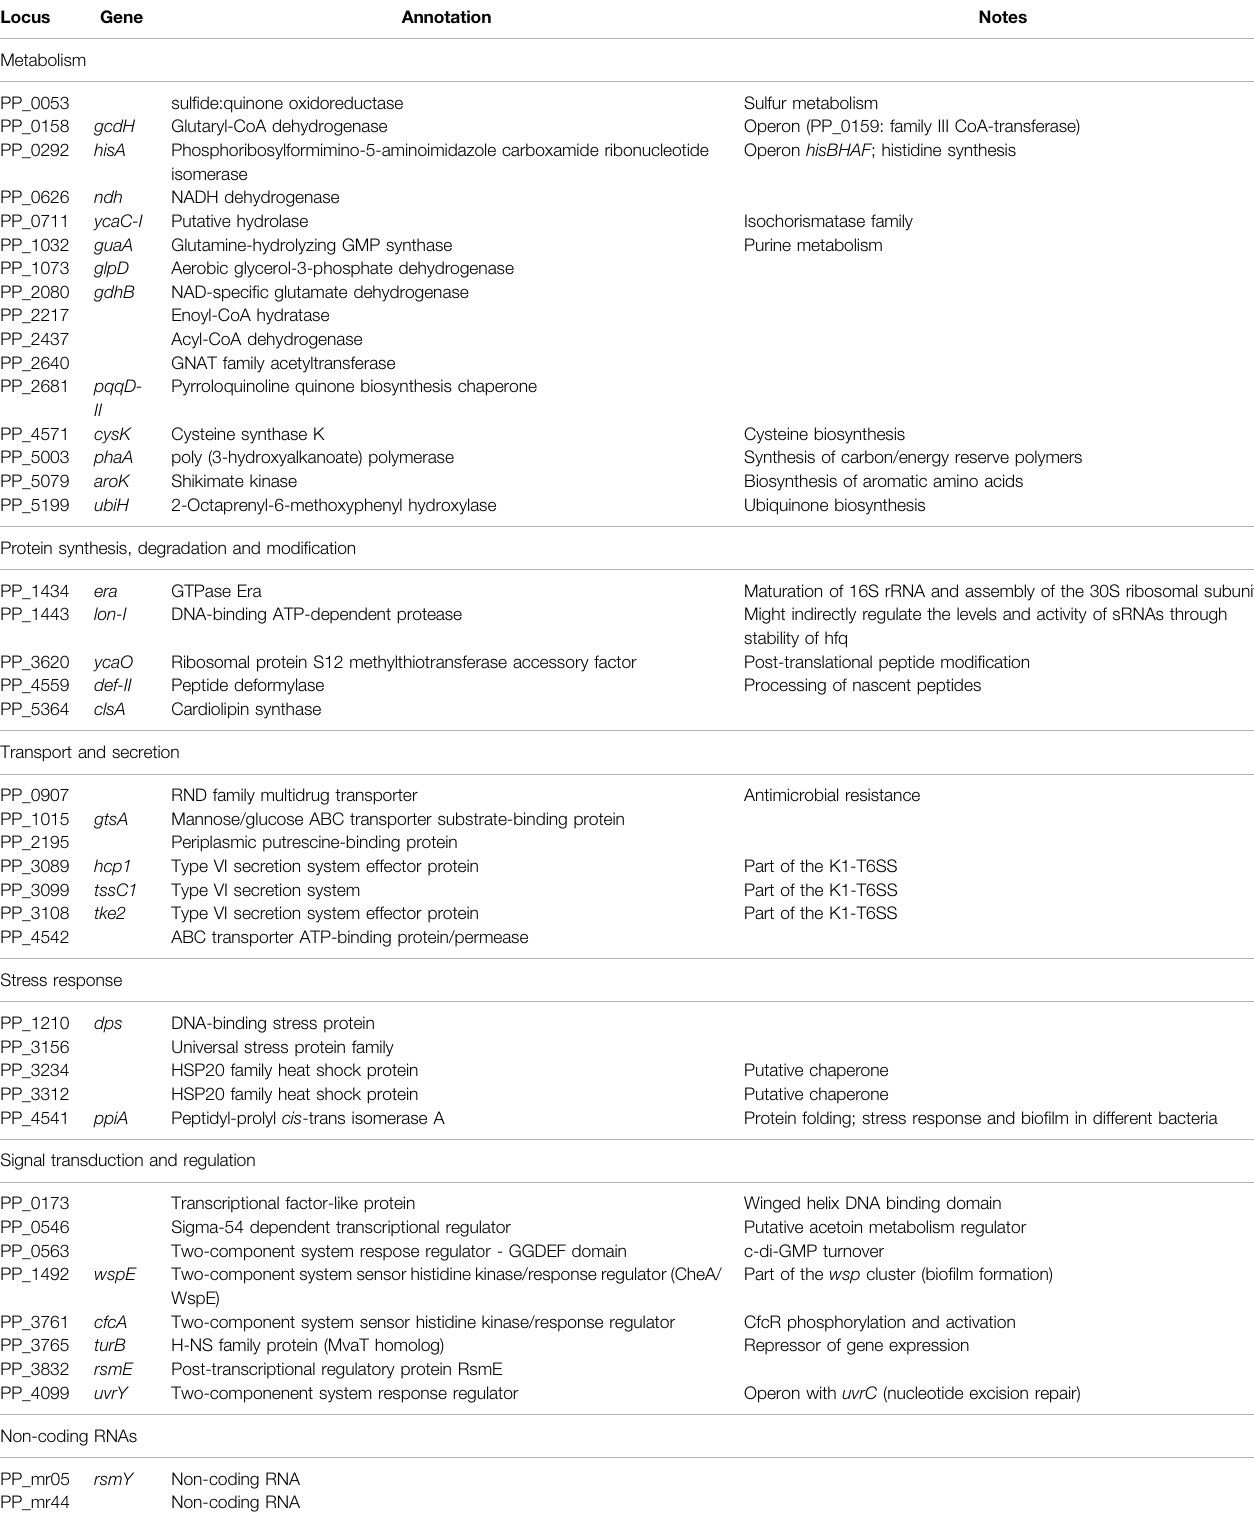
TABLE 3 | Annotation and functional classi fi cation of common targets for the three Rsm proteins in P. putida KT2440. Locus Gene